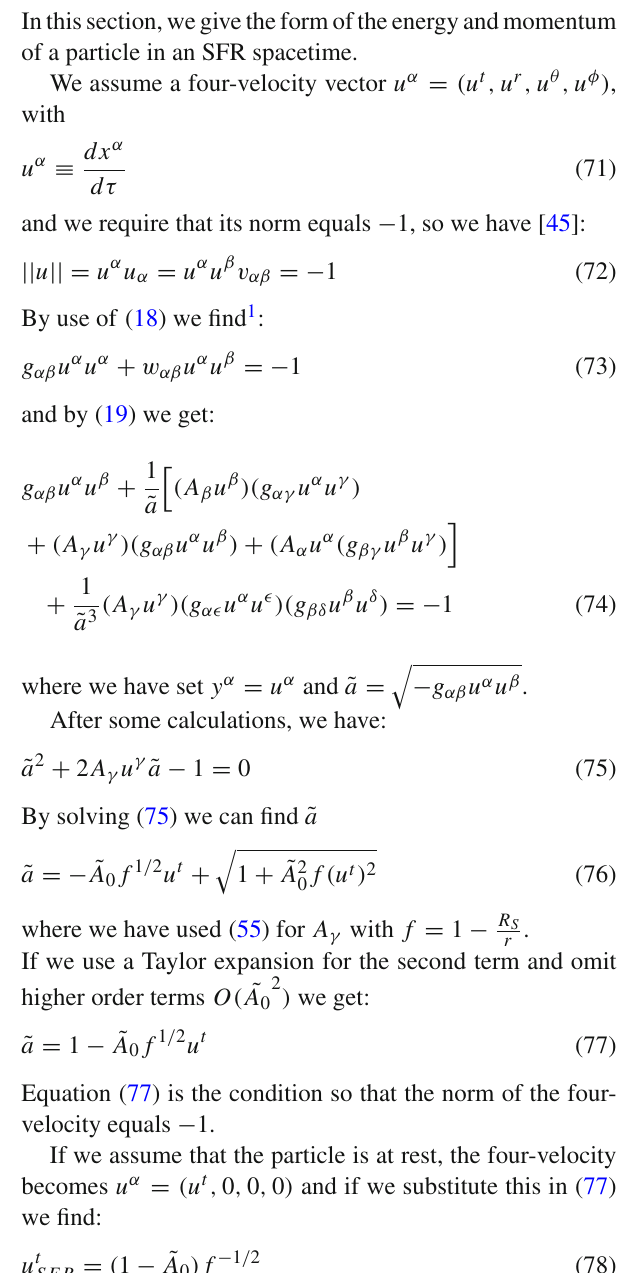
The last two graphs (Figs. 5, 6) represent open paths with a = 1, b = 10 and c = 10. In this case, we can see that the SFR model deviates from GR when we start to move away from the event horizon and the two paths (red and blue) sepa- rate. For a small interval, the paths of the SFR model approx- imate the geodesics of GR. As the radial distance increases, the paths of our model deviate from